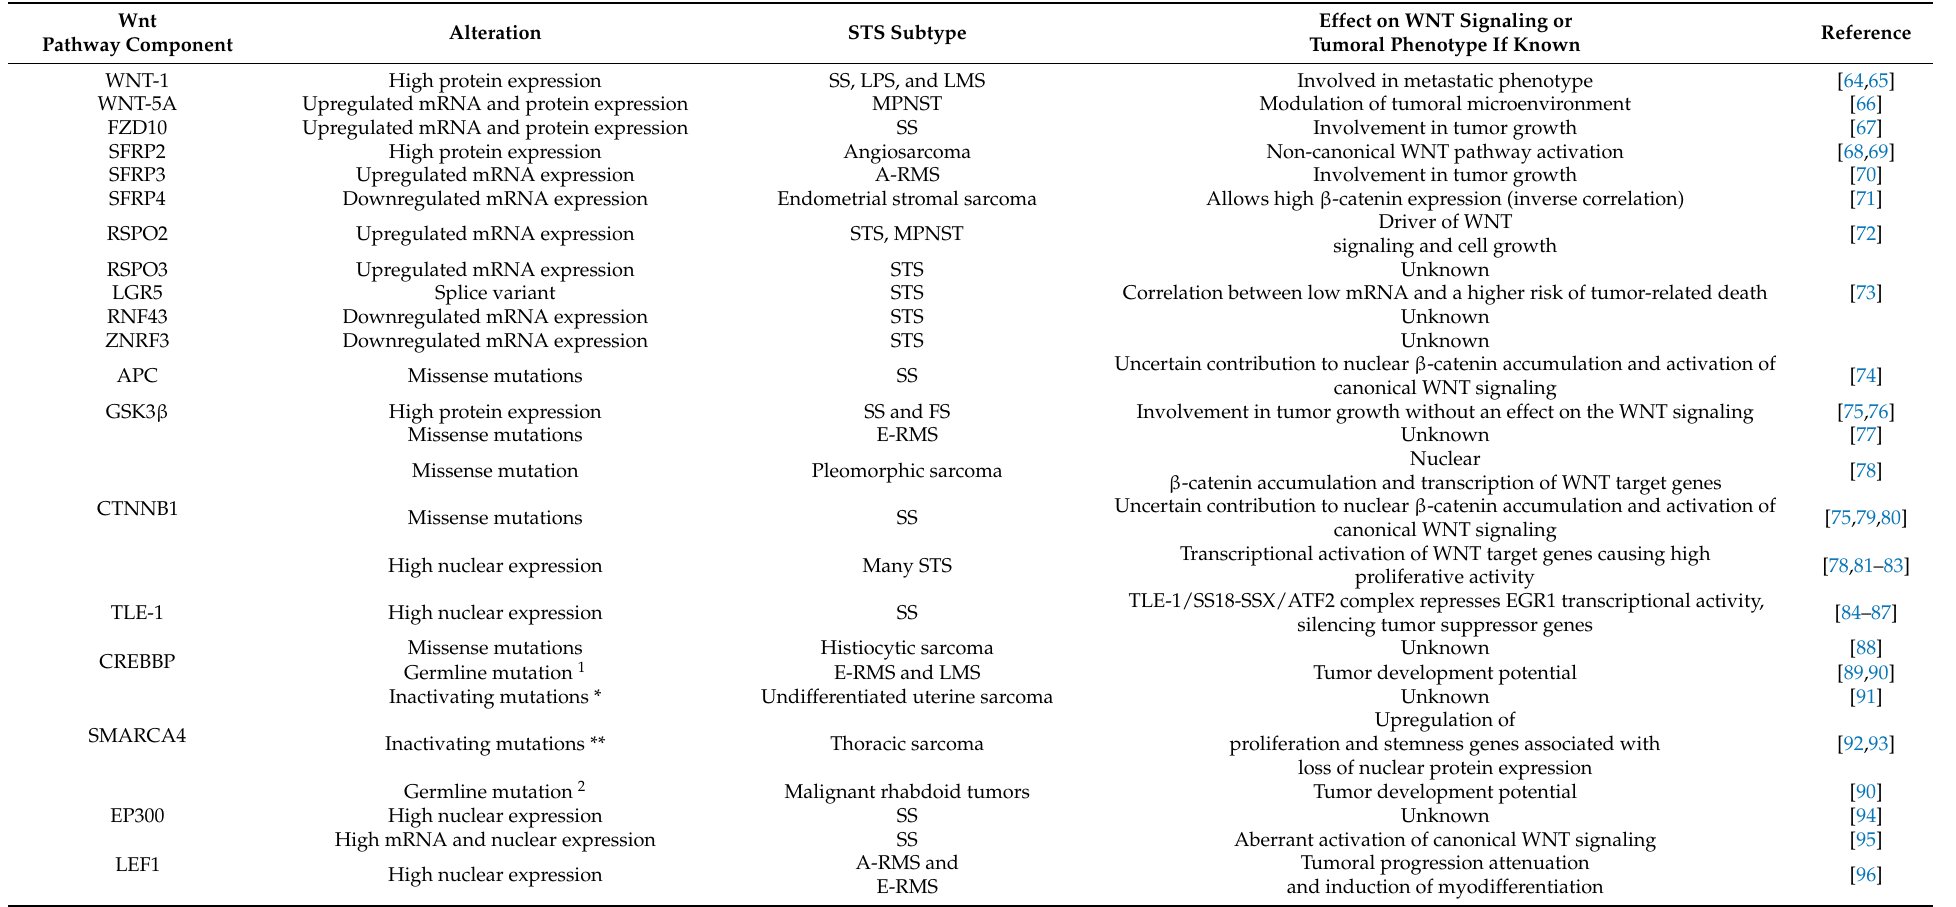
Table 2. Molecular alterations of WNT signaling pathway components in